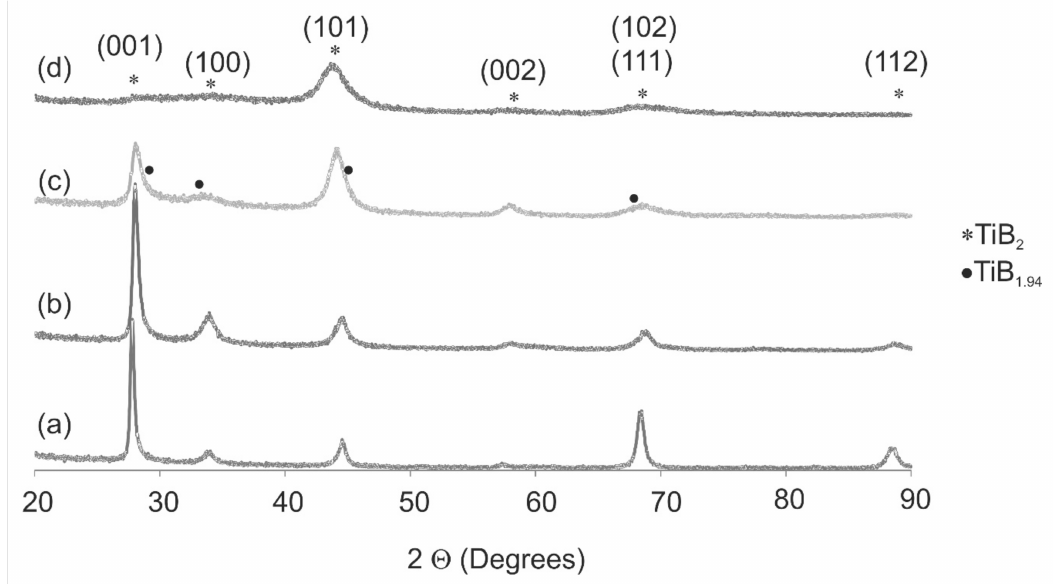
Figure 1. X-ray diffraction patterns for coatings Ti 1 − x W x B 2 ( a ) x = 0, ( b ) x = 0.22, ( c ) x = 0.42, and ( d ) x =